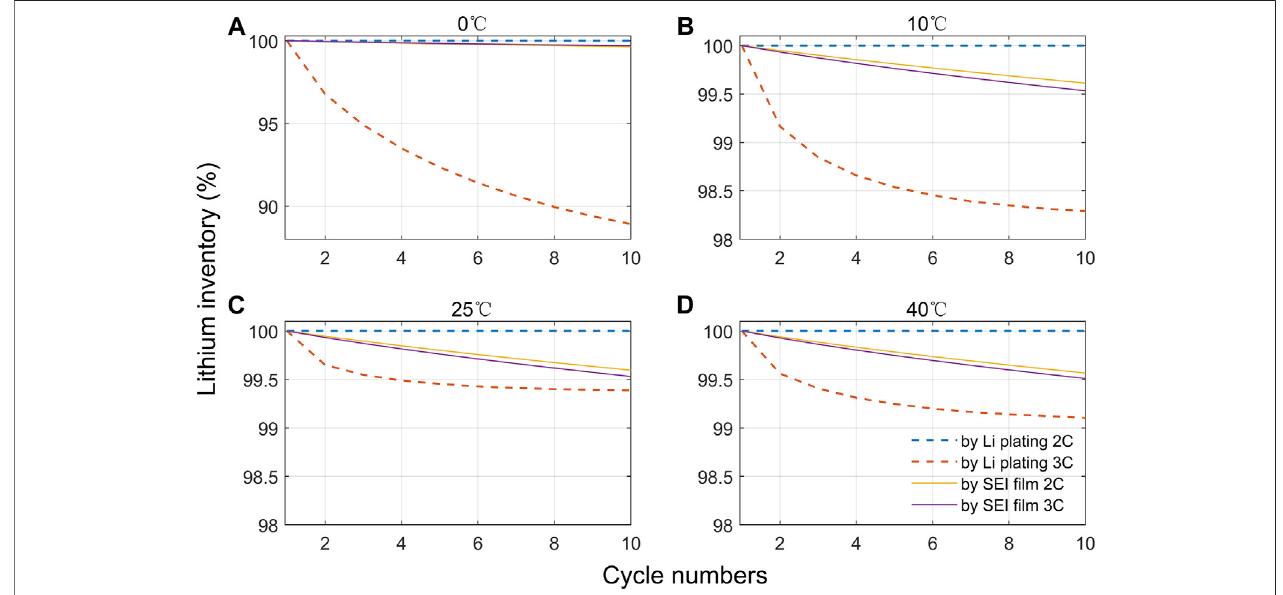
FIGURE 9 | Contributions of lithium plating and SEI fi lm growth charged under different charge rates at different temperatures.